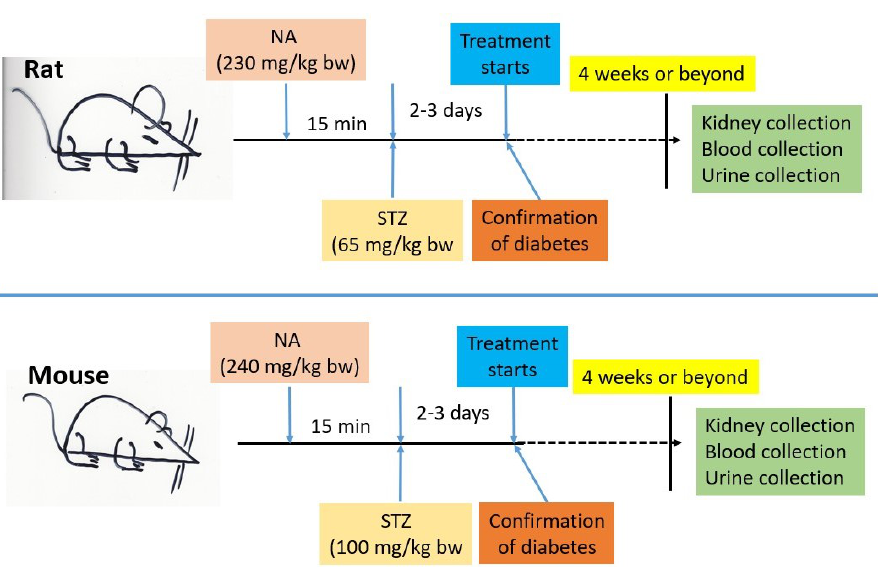
Figure 2. Diagrams showing representative flow charts of non-obese type 2 diabetes animal models induced by nicotinamide and streptozotocin. Renoprotective materials can be tested for their bene- ficial effects by this model, which is also outlined in the diagram. Note that for mice to be used as a model, more than one NA and STZ injection may be performed. Depending on the objective of a given study, the mouse model of NA-STZ diabetes induction may also involve HFD feeding for weeks before NA and STZ administrations (please see the text for a detailed